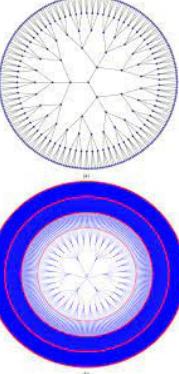
and 6-level pandemic tree Ω 6 5